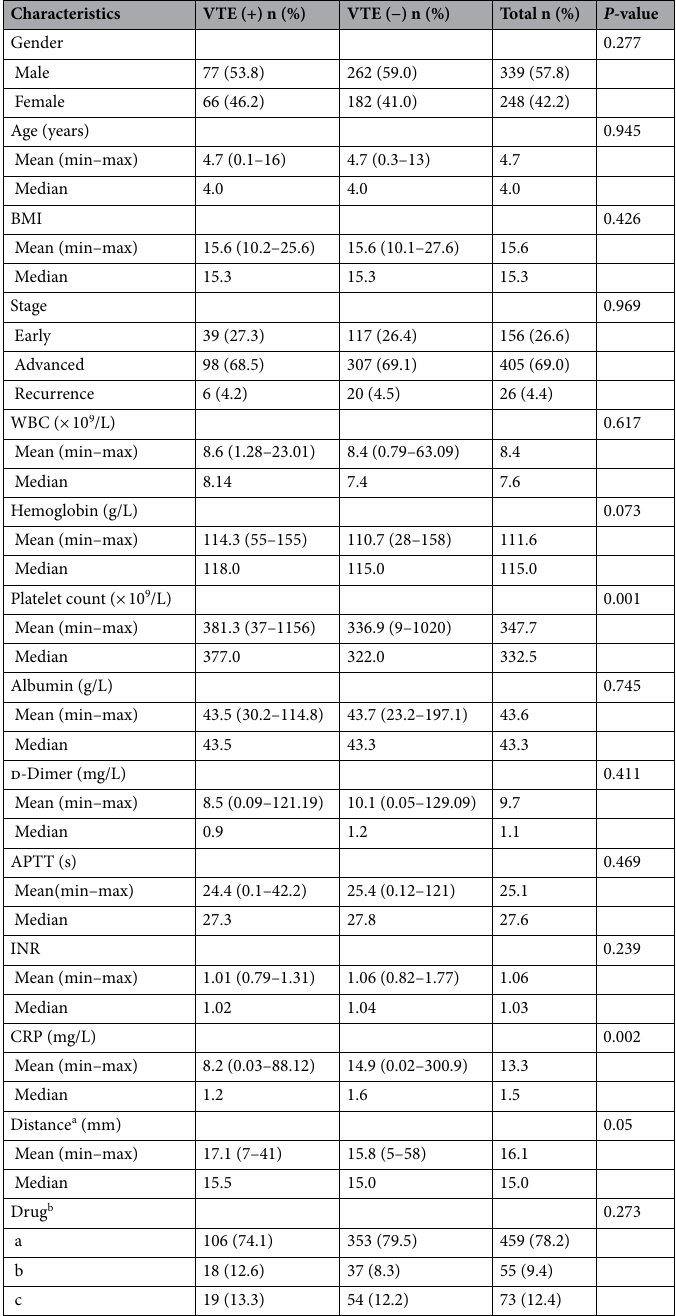
Table 1. Patient characteristics (n = 587). a Distance defines the vertical distance from the highest point of the catheter to the upper border of the left and right extremitas sternalis claviculae. b a: Not use dexamethasone